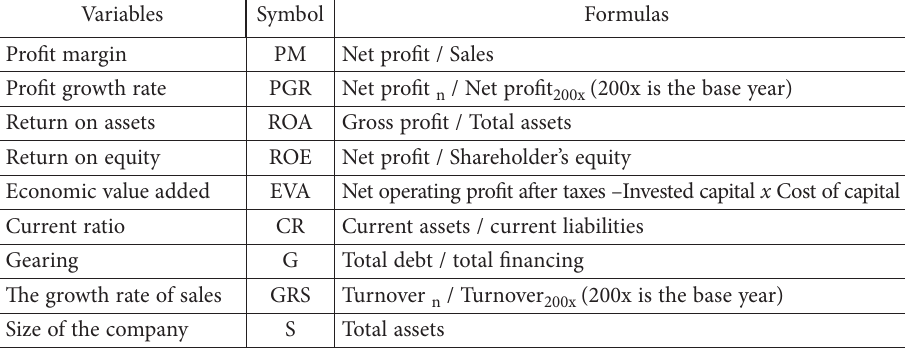
Table 2. Independent and dependent variables (source: elaborated by the authors) Variables Symbol